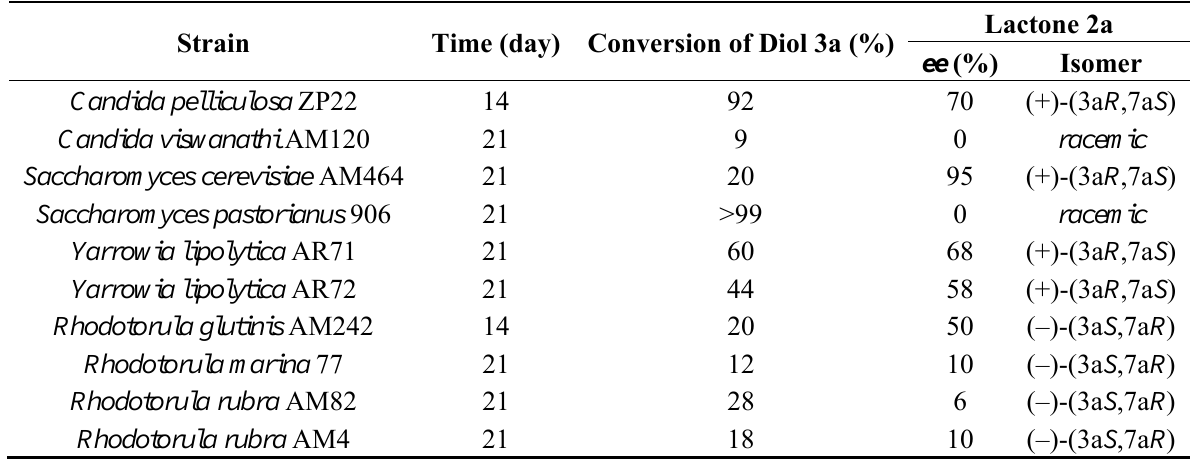
Table 1. The conversion (according to chiral gas chromatography, CGC) of diol 3a in the course of screening-scale oxidation conducted in a microtiter plate